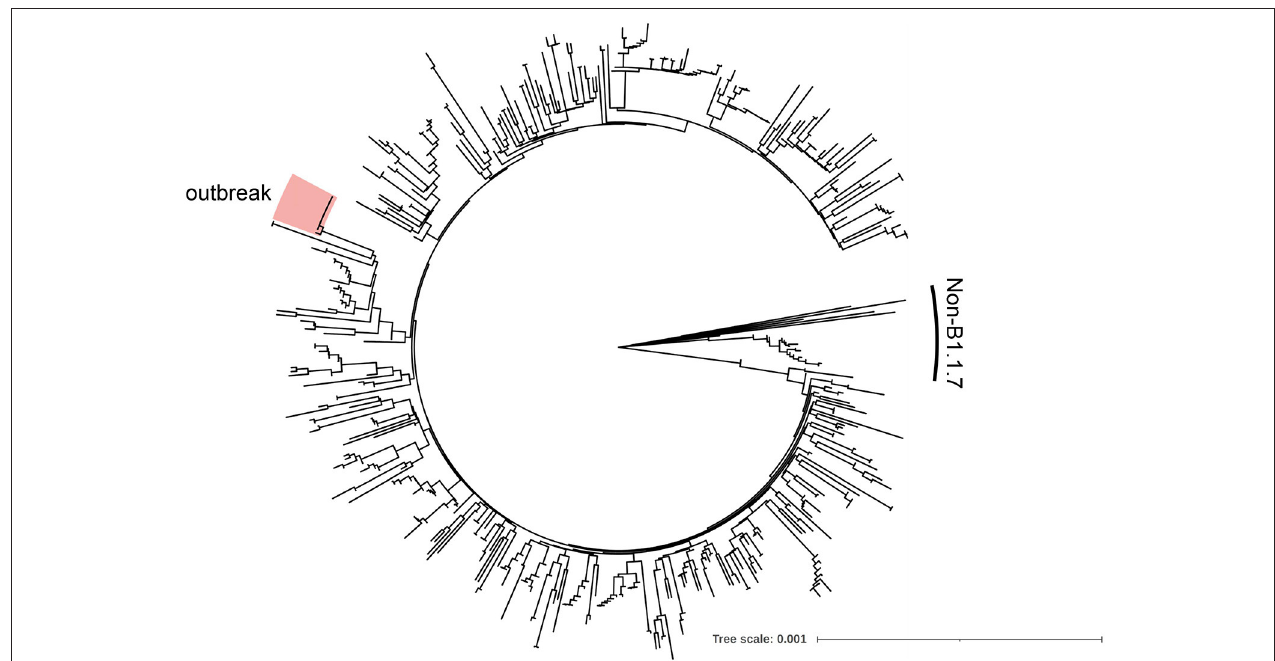
FIGURE 1 | Phylogenetic tree of the outbreak sequences with local SASR-CoV2 isolates. Whole SARS-CoV-2 genome sequences from the outbreak were aligned with 506 local SARS-CoV-2 isolates sampled during the same week [provided by Walker et al. ( 22)] and a phylogenetic tree was calculated by the Neighbour-Joining method using the Tamura-Nei genetic distance model utilising the software Geneious R.10.2.6 and visualized with iTOL6.3 (23). The outbreak samples are highlighted in red. Non-B1.1.7 sequences are indicated.